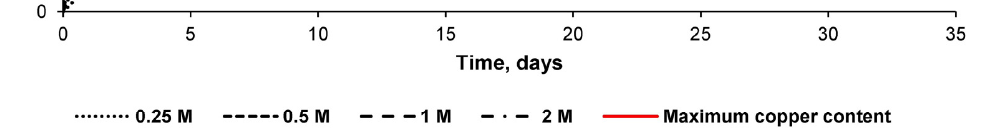
Figure 7. Graph of leachate copper concentration as a function of time for 0.25 mol, 0.50 mol, 1.00 mol, and 2.00 mol sulfuric acid solutions.